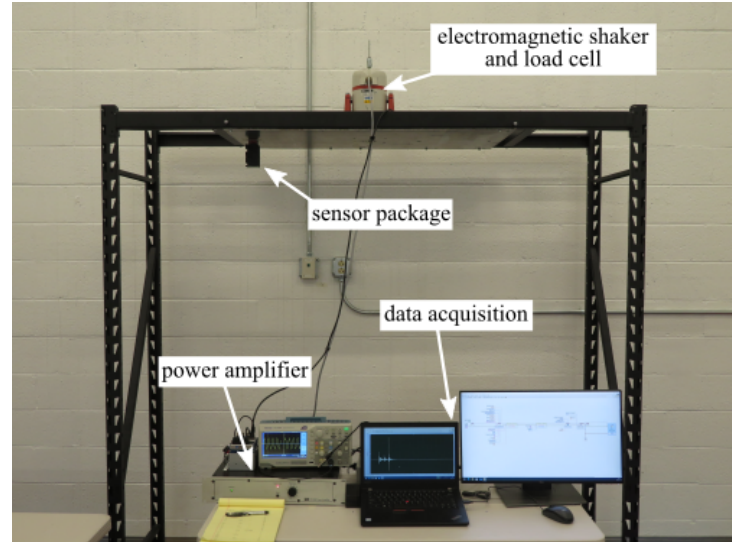
Figure 6. Overview of the test apparatus with key components